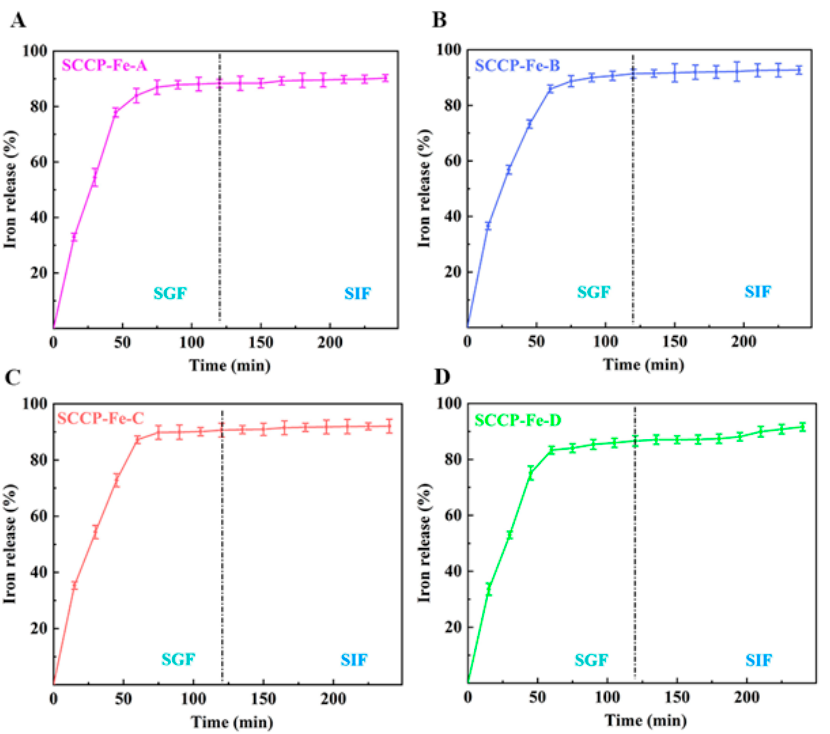
Figure 6. The iron (III) release in simulated gastric fluid (SGF) and simulated intestinal fluid (SIF) of four sweet corn cob polysaccharide-iron (III) complexes (( A ): SCCP-Fe-A; ( B ): SCCP-Fe-B; ( C ): SCCP-Fe-C; ( D ): SCCP-Fe-D).